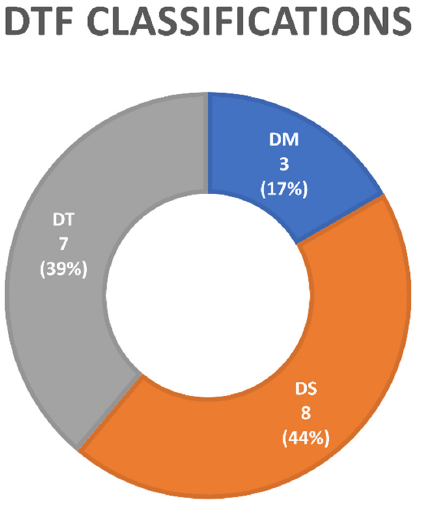
Figure 5. Population of each classification of DTF reviewed in this work.